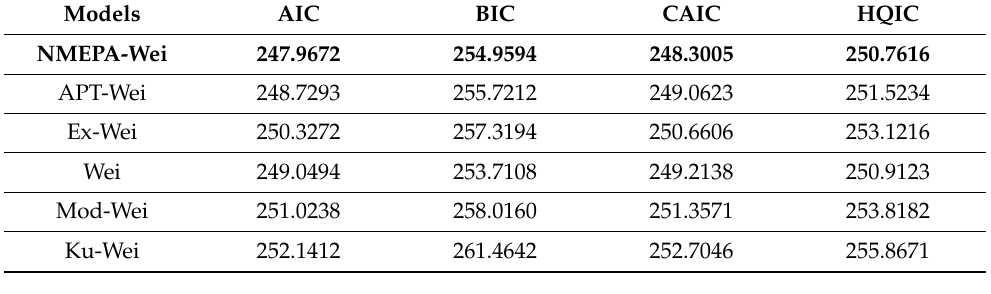
Table 8. The discrimination measures values of AIC, BIC, CAIC, and HQIC measures of competitive models using fatigue fracture data set (Data set 2).